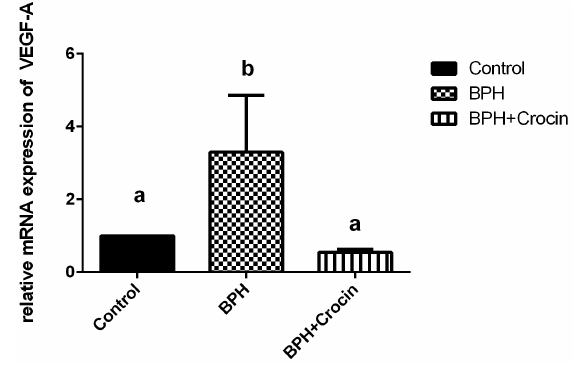
Fig. 5. VEGF-A mRNA expression in the experimental rats showing the effect of crocin treatment. The data represent the mean ± SEM. Means with different superscript letters are sig- nificantly different from one another ( P < 0.05). Abbreviations: BPH, benign prostatic hyperplasia; VEGF-A, vascular endothelial growth